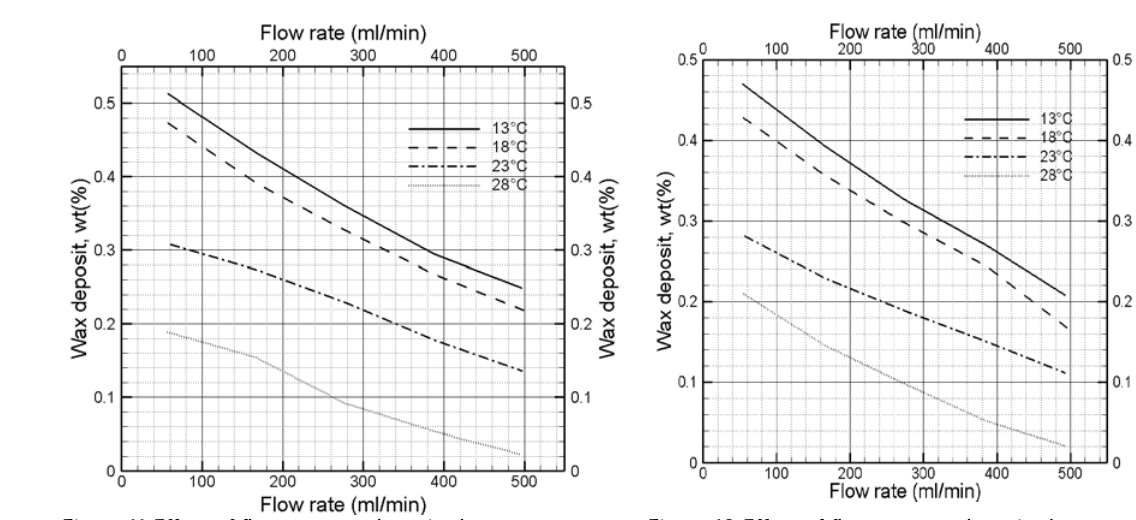
Figure 11 Effect of flow rate on deposited wax percentage at 9 min (Kelechukwu et al., 2010)